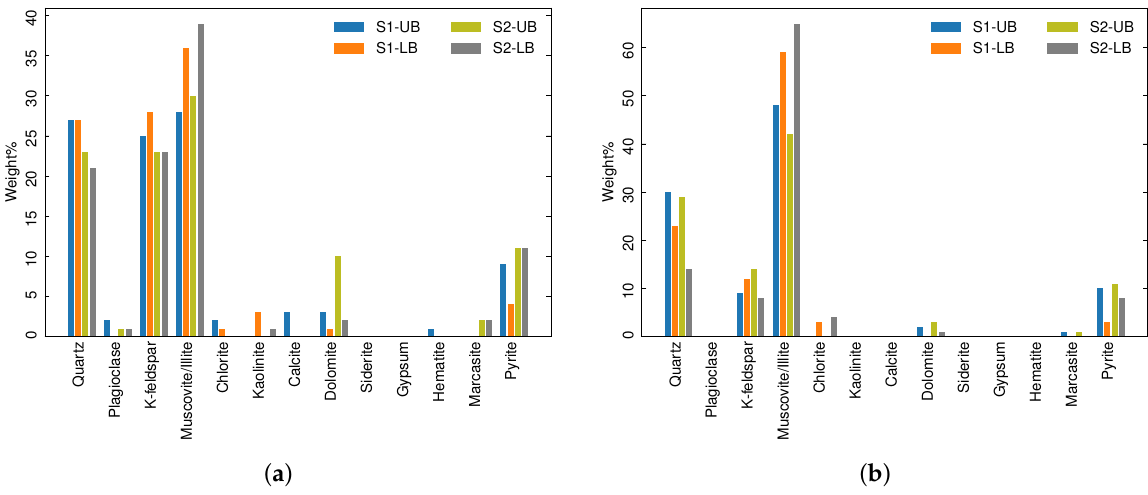
Figure 7. ( a ) The quantitative mineralogy data from the XRD; ( b ) the semi-quantitative mineralogy data of the clay sized